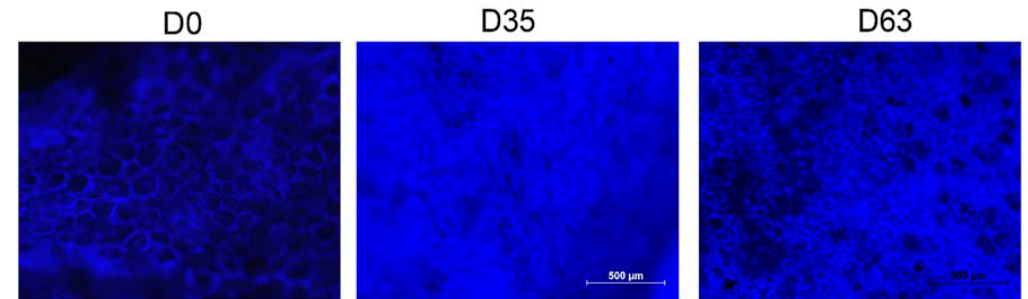
Figure 7. Tissue sections of persimmon cv. Rojo Brillante flesh submitted to drying observed by light microscopy (D means days of drying).